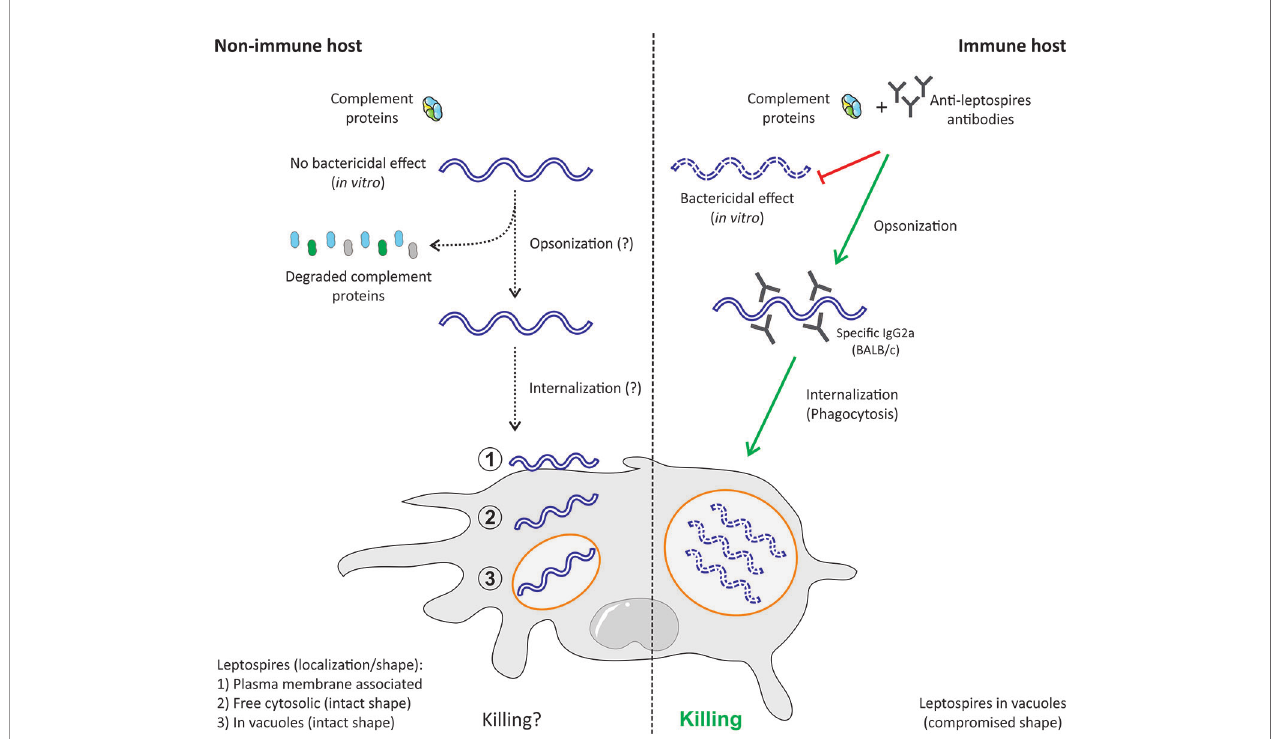
FIGURE 1 | Effects of opsonization on leptospire survival in macrophages. Leptospira interrogans are resistant to nonimmune serum and have evolved diverse mechanisms to avoid the complement system. In contrast, immune serum exerts a bactericidal effect on leptospires. Preincubation of leptospires with immune serum containing anti-leptospires antibodies (Abs) leads to rapid internalization and killing of leptospires by macrophages. In this case, leptospires are exclusively found in vacuoles, in which they have compromised shapes. When leptospires are incubated with naive serum, their internalization seems to be slower, and several populations can be identi fi ed inside and outside macrophages: (1) plasma membrane-associated, (2) free in the cytosol, and (3) or in vacuoles. In this case, vacuolar leptospires do not seem to have a compromised shape (12,